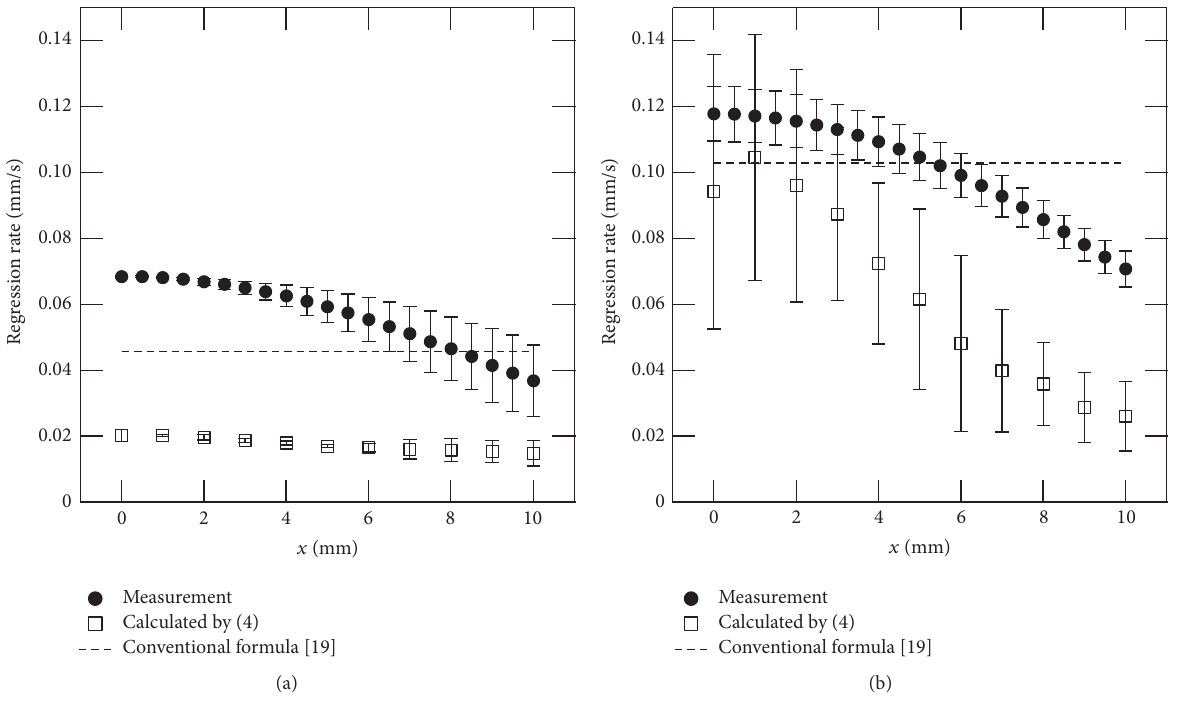
Figure 7: Comparison of local regression rates for (a) V = 1.9 m/s and (b) 5.6